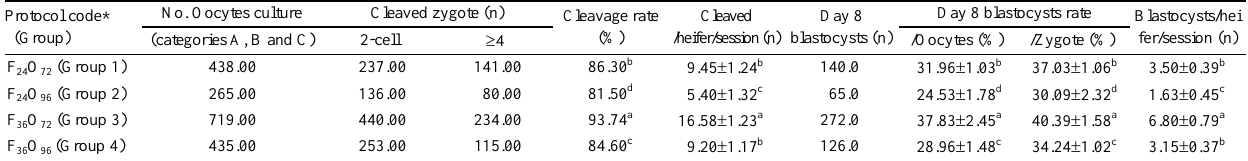
* Protocol code (Group), a single dose i.m. administration of 100 mg FSHp at 24 h and OPU at 72 (F 24 O 72 ; Group 1) or 96 h (F 24 O 96 ; Group 2), and a single dose i.m. administration of 100 mg FSHp at 36 h and OPU at 72 (F 36 O 72 ; Group 3) or 96 h (F 36 O 96 ; Group 4) after follicular ablation.